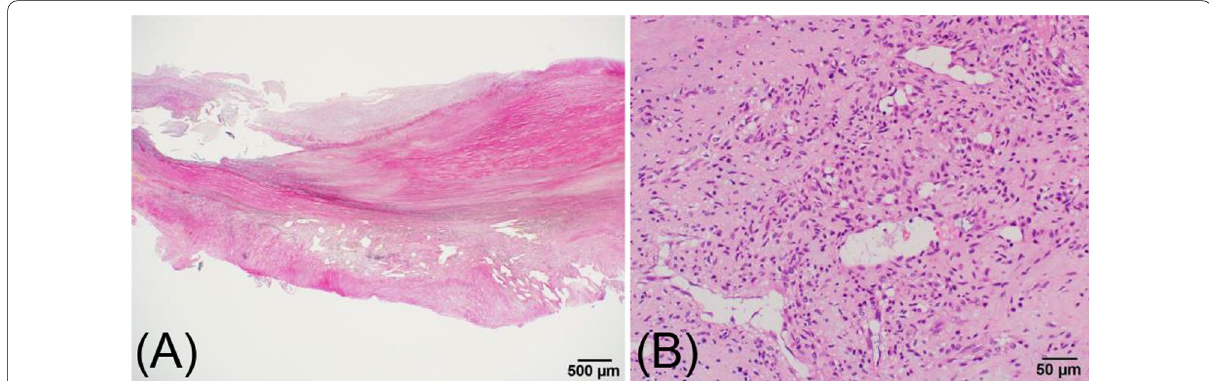
Fig. 2 A Photomicrograph ( 2, scale bar 500 μm) by elastica van Gieson staining showed fibrous tissue with granulation and degeneration. B × = Photomicrograph ( 200, scale bar 50 μm) by hematoxylin and eosin staining showed granulation tissue and degenerated collagen fibers, with × = microvasculature, fibroblast, and inflammatory